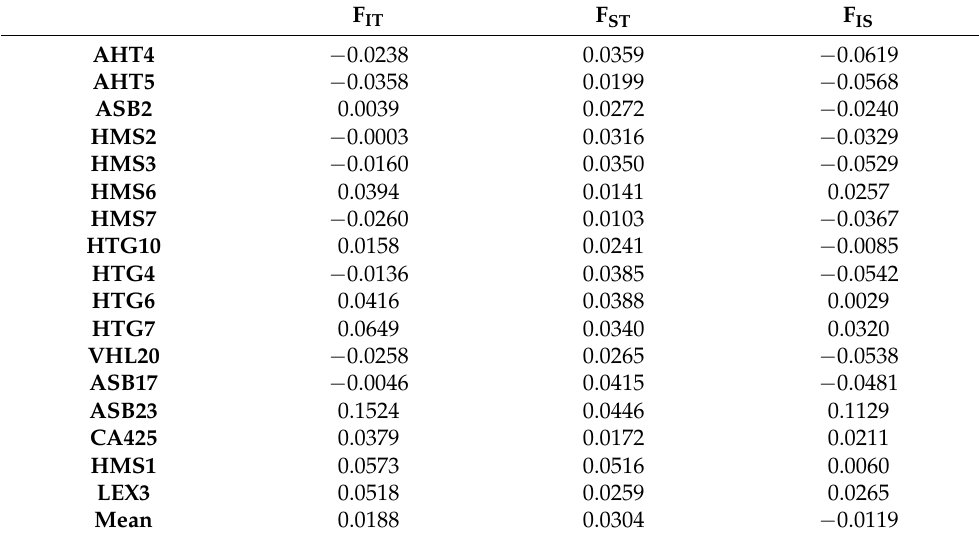
Table 1. Genetic structure coefficients for each locus (F-statistics).